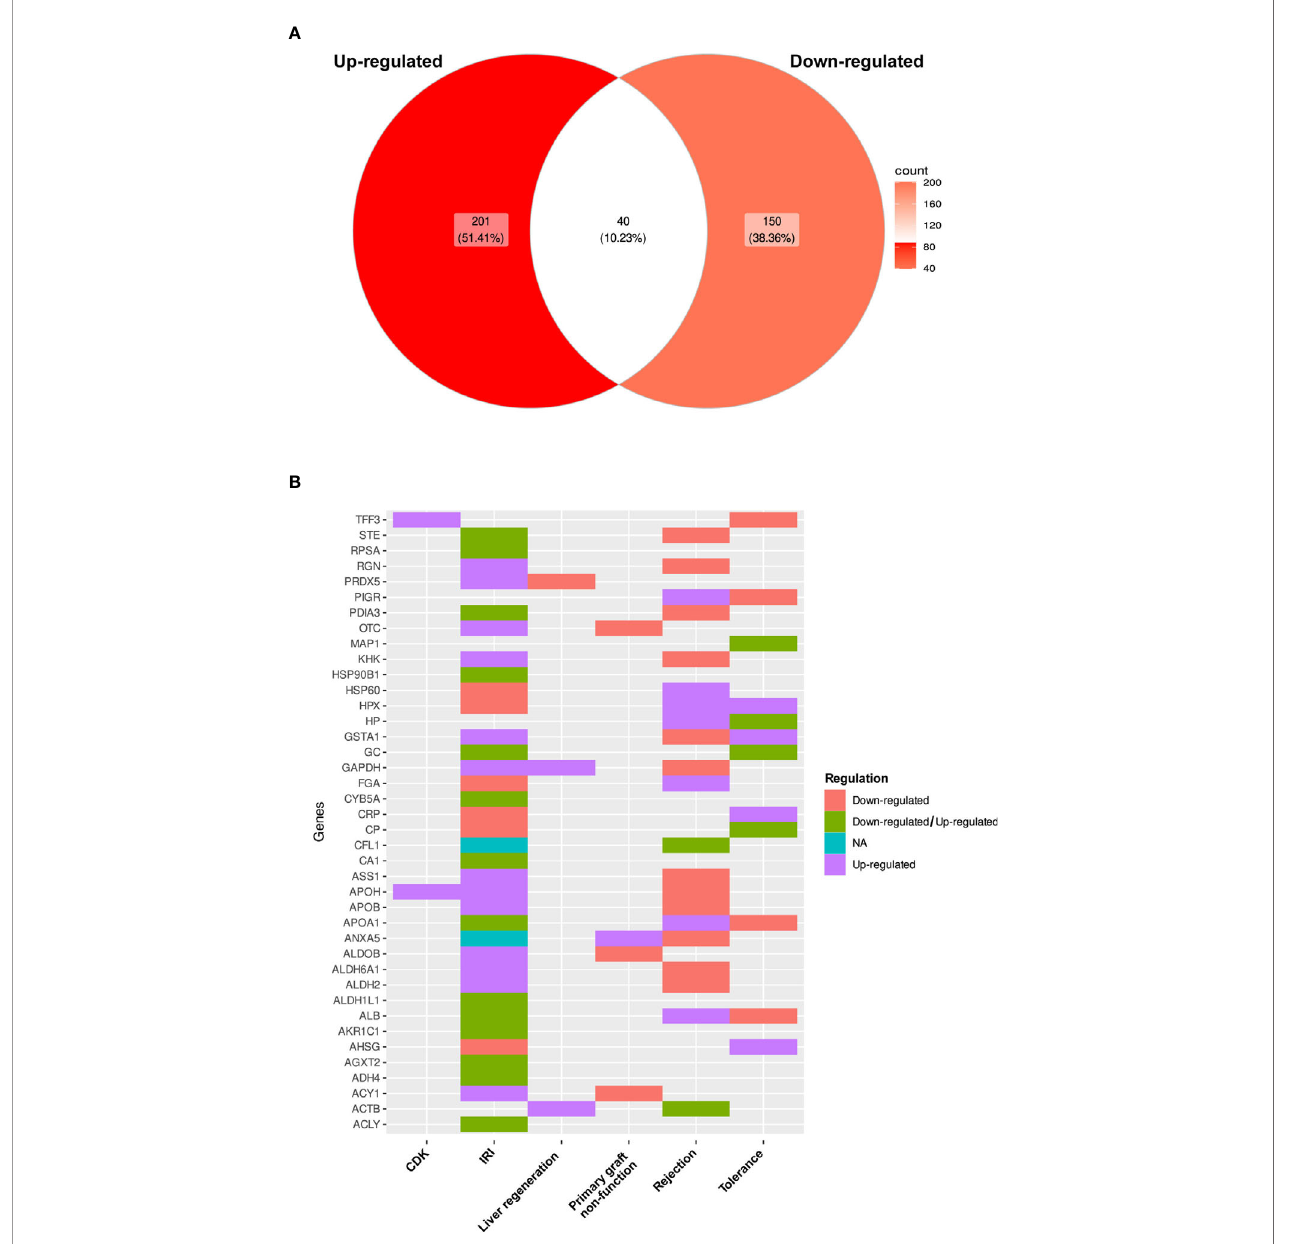
FIGURE 4 | Differential pattern of protein expression. (A) Comparison of differential expression patterns observed for proteins among all selected studies expressed as a Venn diagram. (B) Heat plot of the list of proteins that had evidence supporting both types of expression